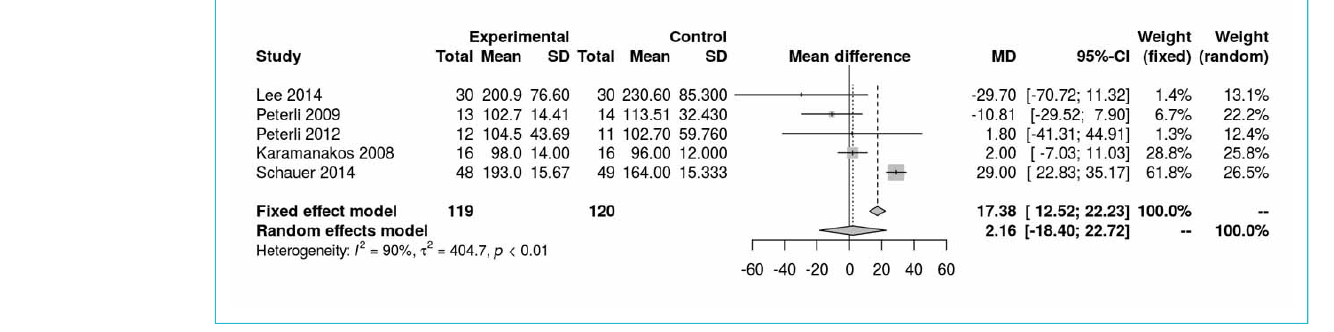
Figure 2a: Fasting blood glucose at